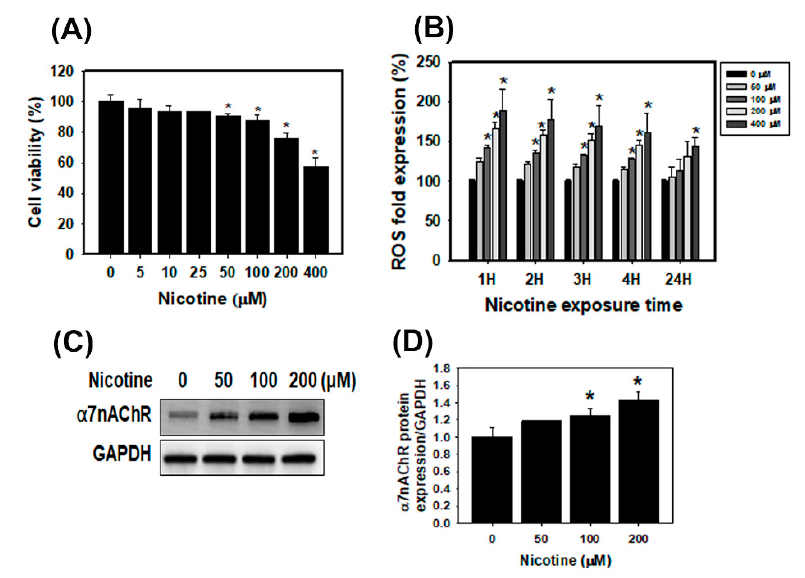
Figure 1. The effects of nicotine on cell viability, ROS generation and α 7nAChR expression in human tubular epithelial cells HK-2. ( A ) Cell viability was analyzed using the SRB assay. The HK-2 cells were treated with various concentrations of nicotine for 24 h. * p < 0.05 compared with the control. ( B ) ROS generation was assessed using the ROS detection assay kit. The HK-2 cells were treated with various concentrations of nicotine for 1, 2, 3 or 24 h. * p < 0.05 compared with the control. ( C ) Western blot analysis was used to assess the expression of the α 7nAChR protein in HK-2 cells. The cells were treated with the various concentrations of nicotine for 24 h. ( D ) The α 7nAChR protein expression of the histogram represents the average normalized densitometric values. GAPDH was used as the internal control. Data are presented as the means ± standard deviation of three independent experiments. Statistical significance was estimated with ANOVA by Dunnett’s multiple comparison test.